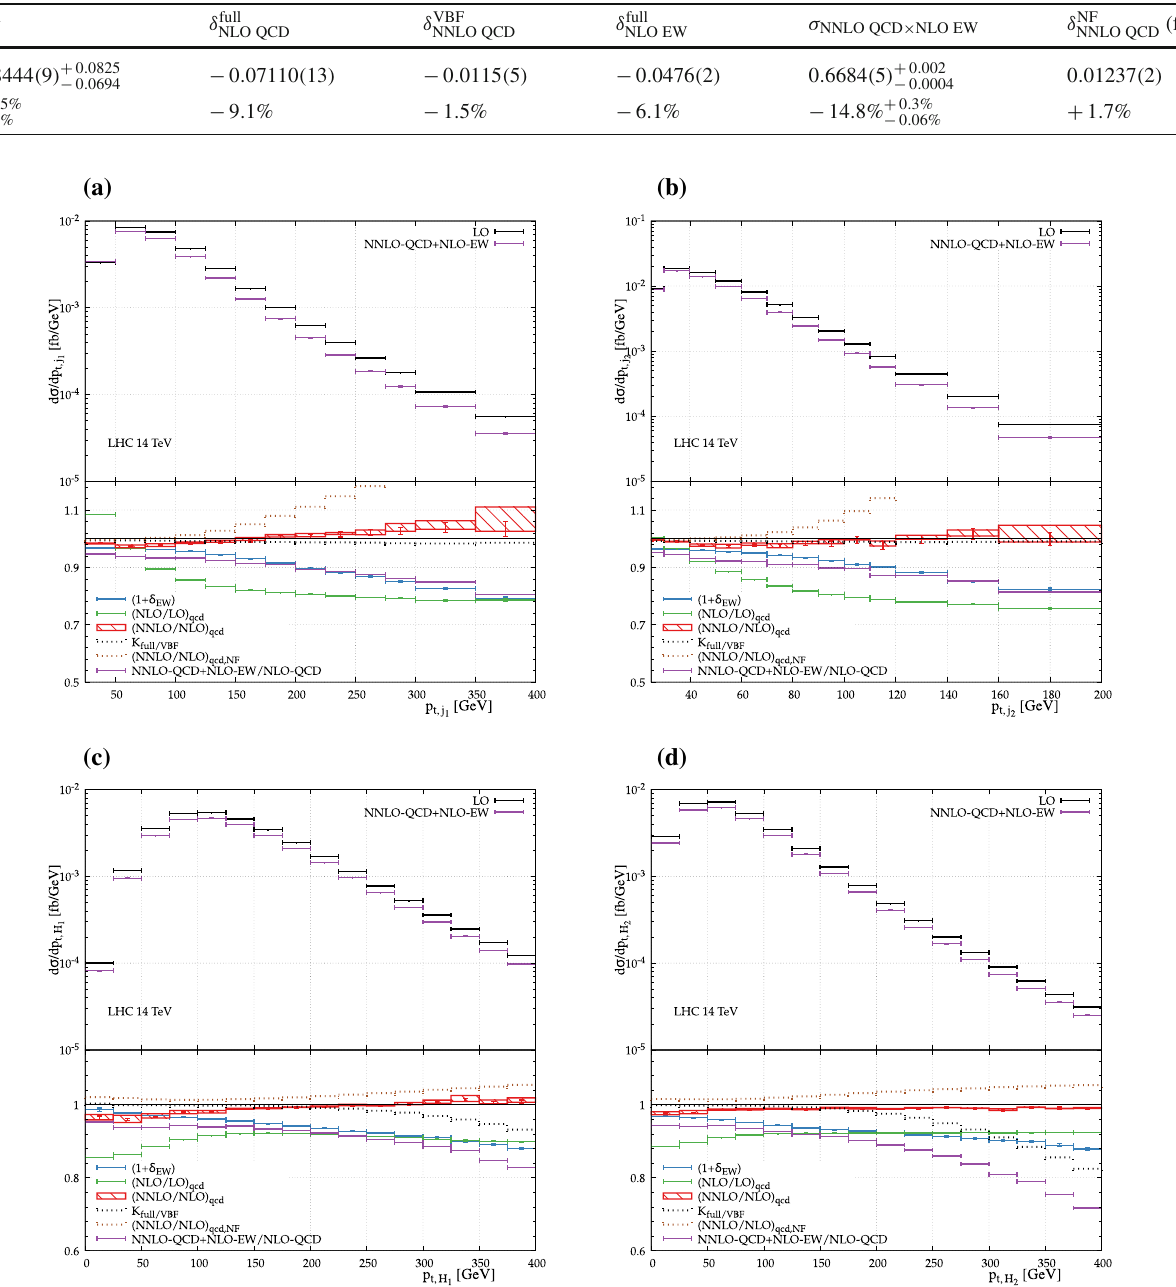
+ NLO EW and the LO prediction. The lower panel shows the relative corrections. The bands denote the envelope of the QCD scale variation. Note that the non-factorisable corrections to the transverse momenta of the jets should not be trusted at large values, as the underlying eikonal approximation breaks